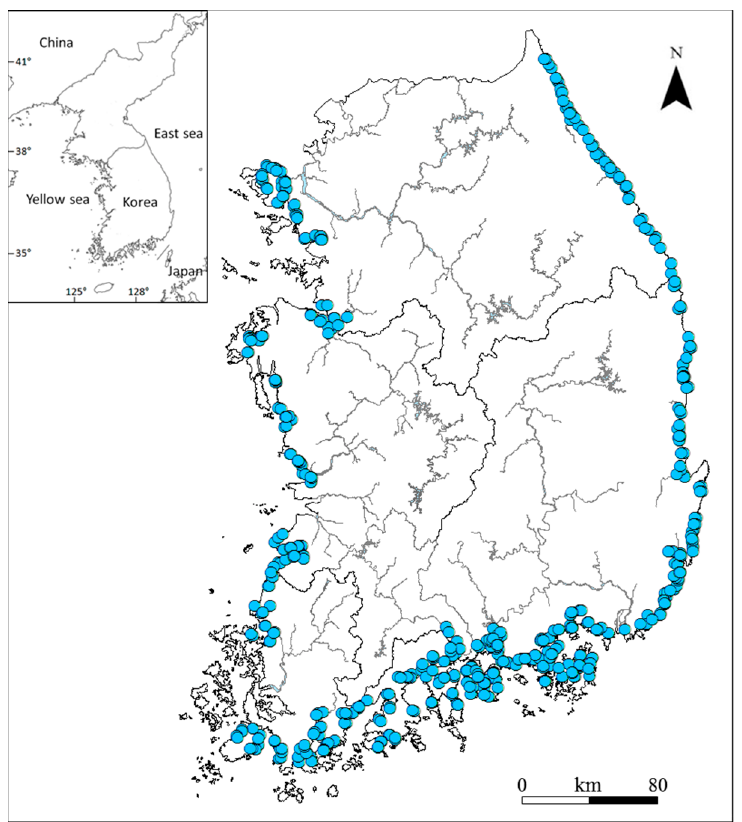
Figure 1. A map showing the 512 sampling stations for the water and diatom sampling in Korean estuaries between 2009 and 2016.